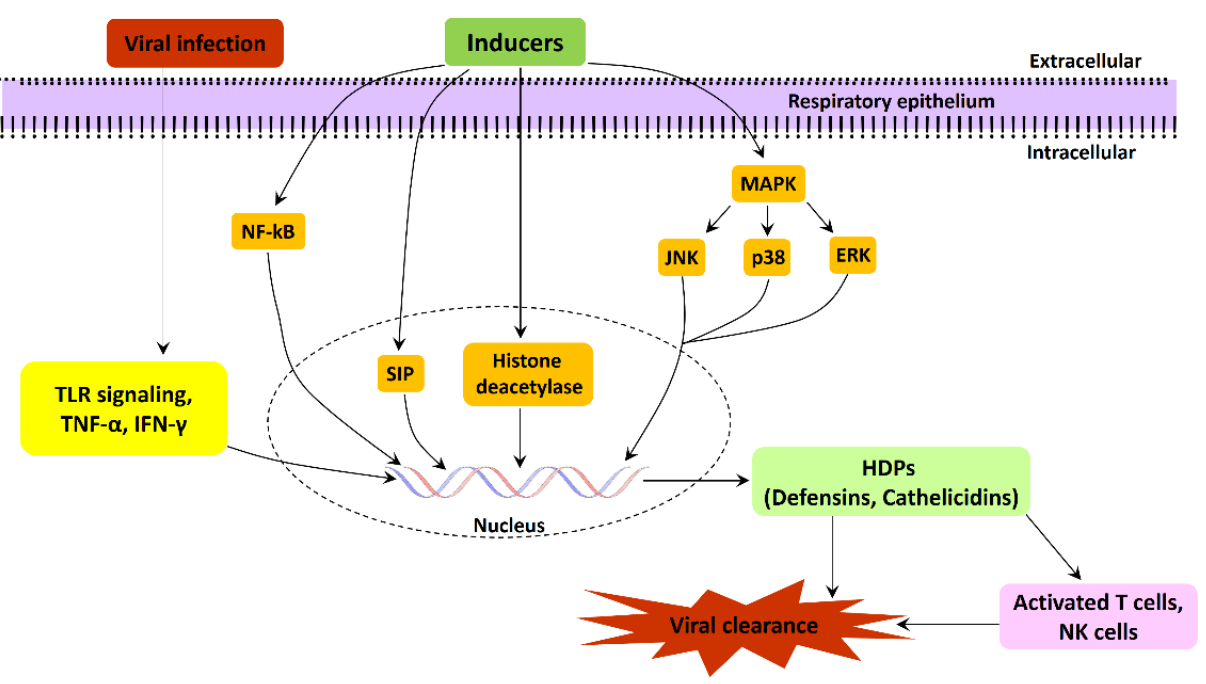
Figure 1. Schematic representation of various signaling pathways involved in the gene expression regulation of AMPs during respiratory tract viral infections.